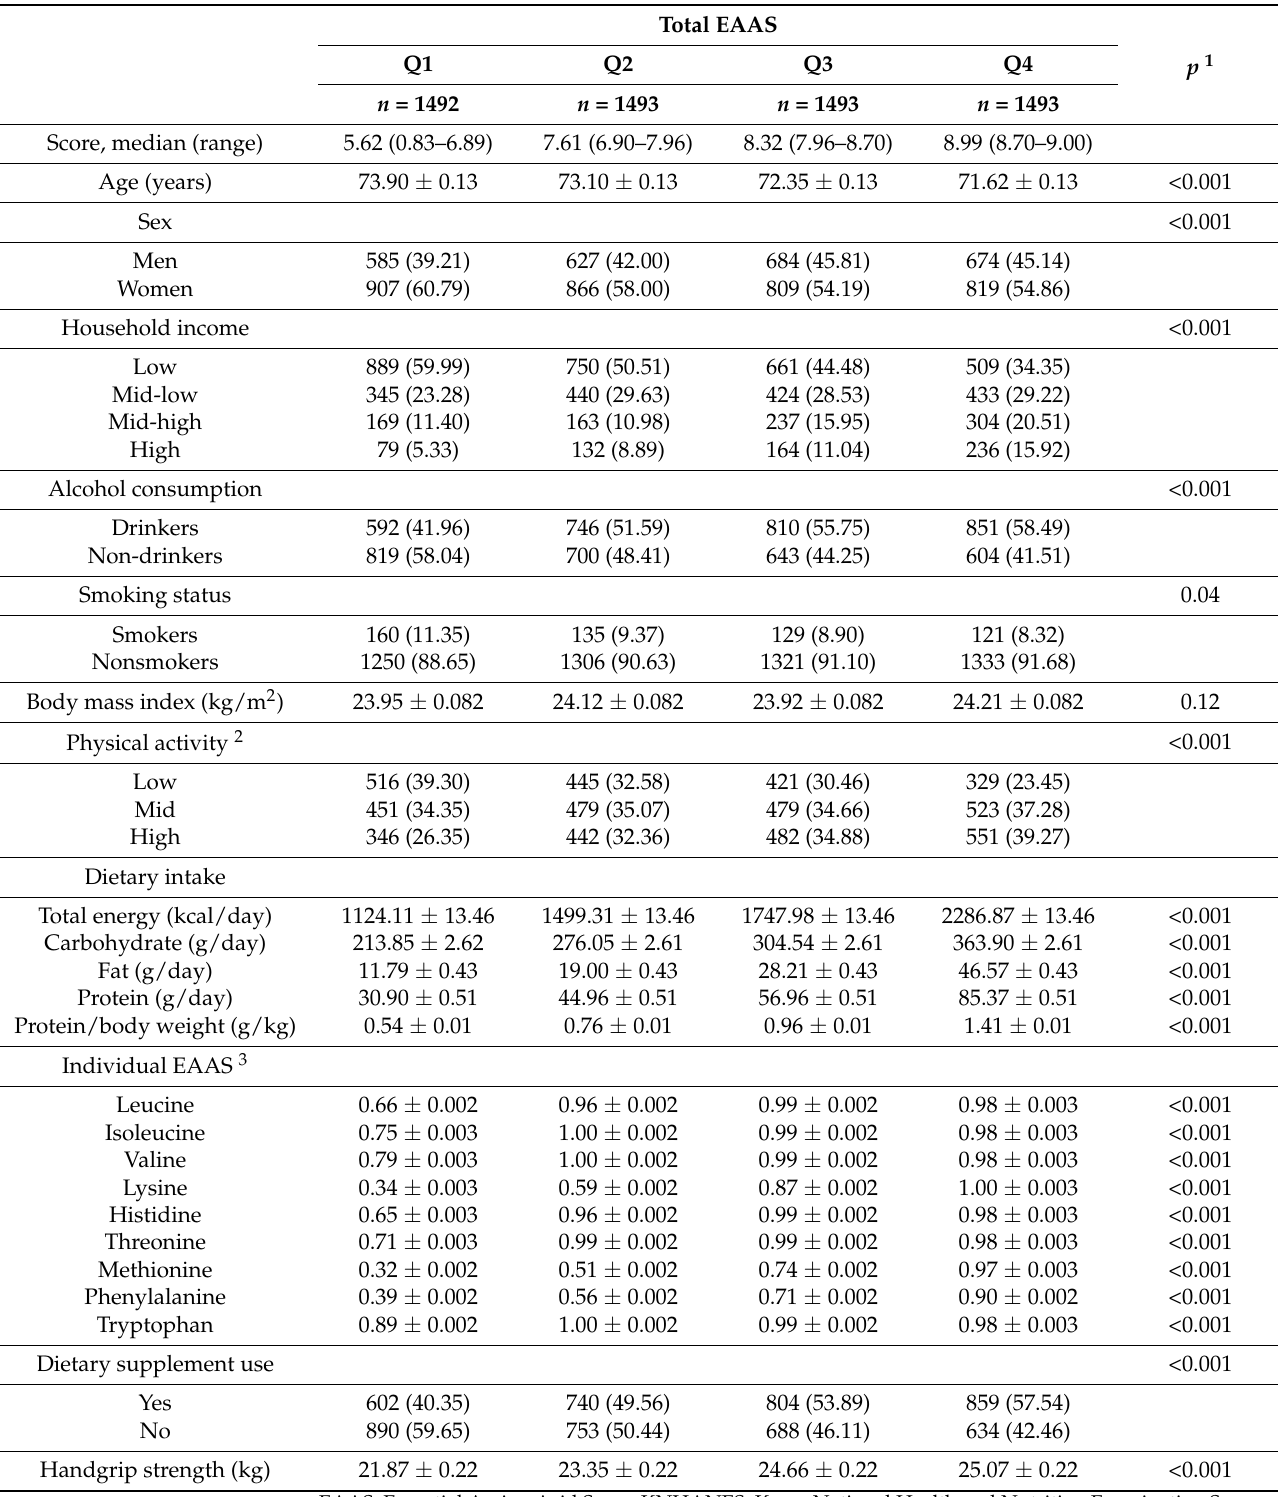
Table 1. General characteristics of the participants according to total EAAS, KNHANES 2014–2019 ( n =